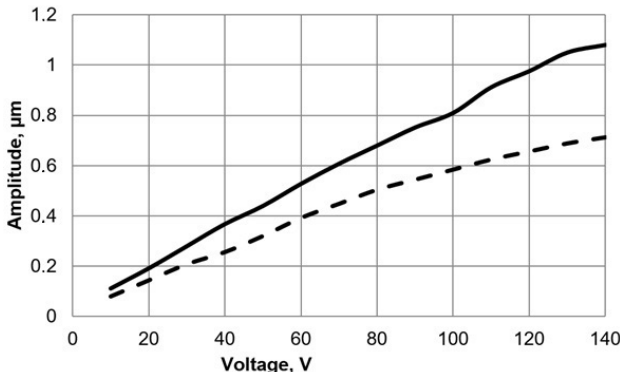
Figure 15. Amplitude vs applied voltage of the axial vibrations of contacting element at the operational frequency 93.6 kHz: dashed line—when the triangle-shaped electrode tip is directed to an active contacting element; solid line—when the triangle-shaped electrode tip is directed backwards to the active contacting